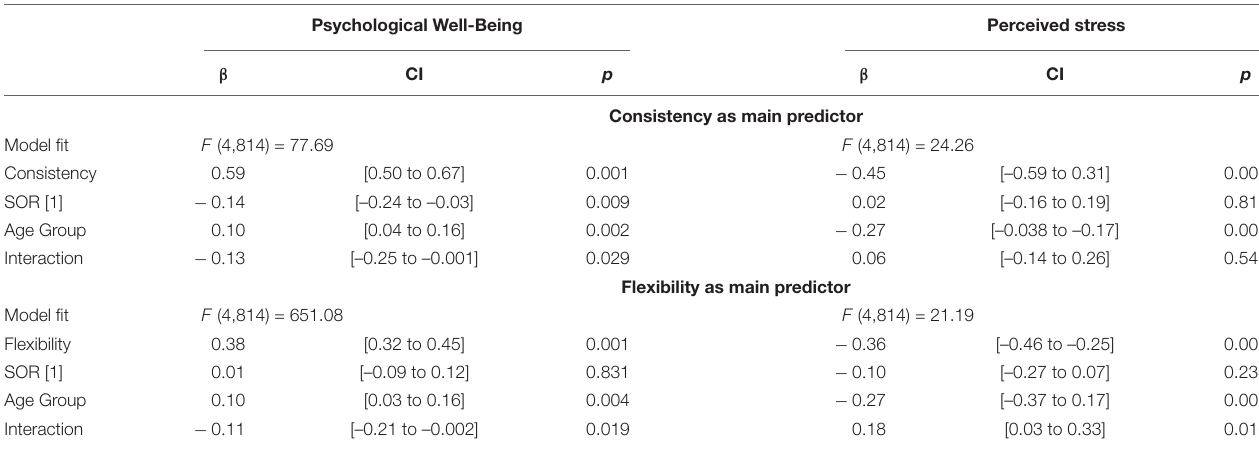
TABLE 6 | Study 3: Results of moderation analyses with Self/Others Ratio as the